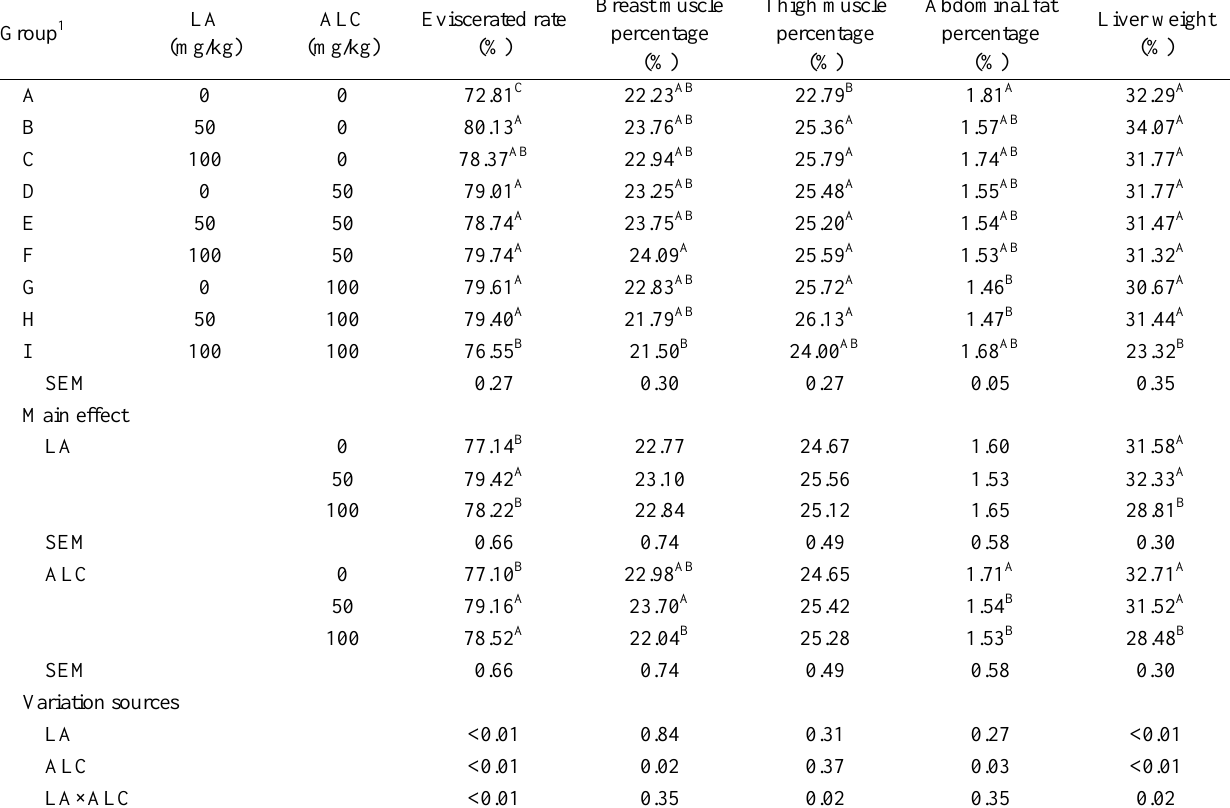
Table 3. Effects of dietary LA and ALC on carcass characteristics of broilers Group